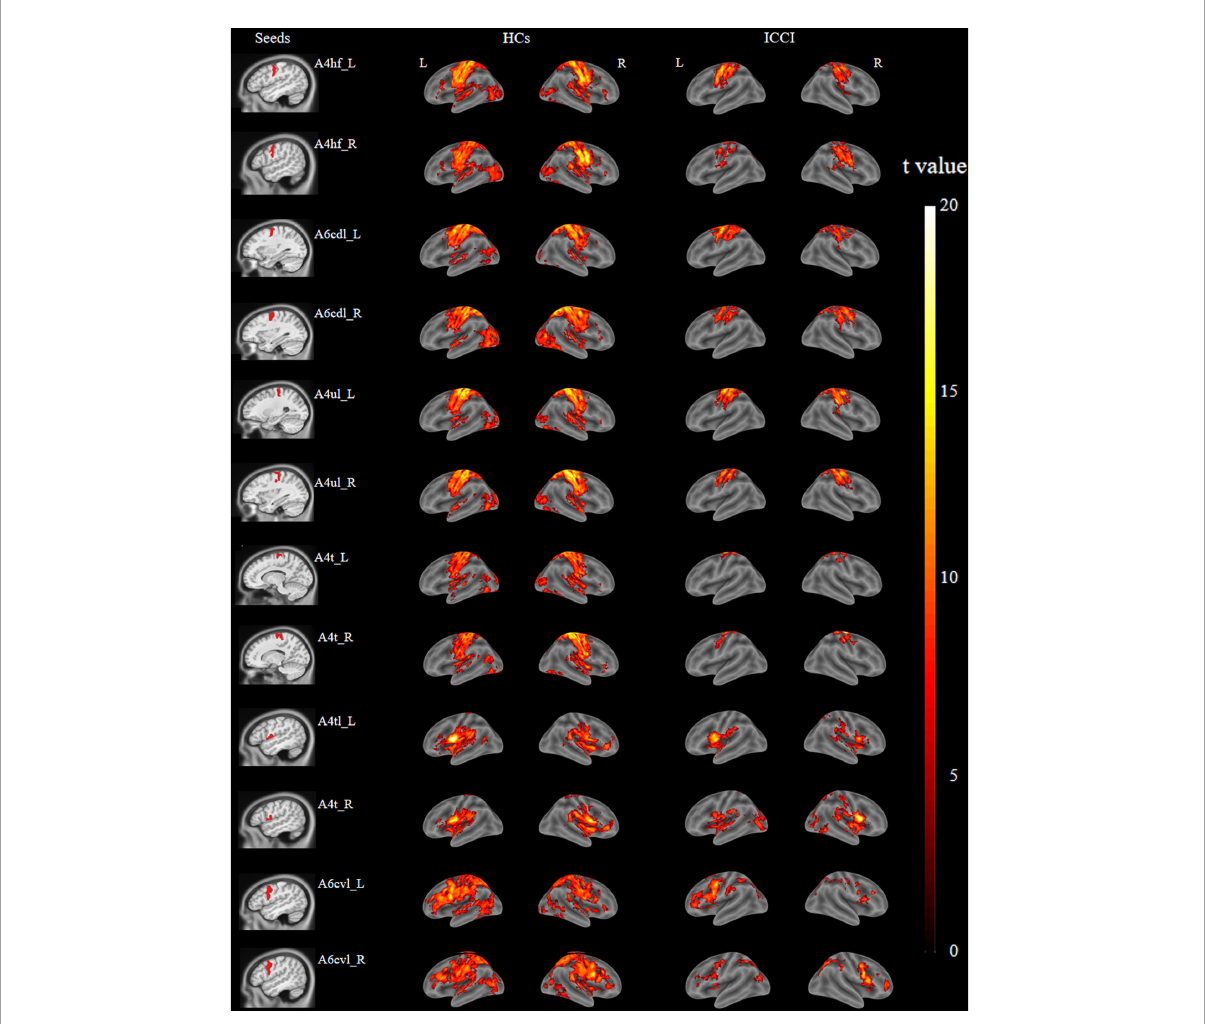
FIGURE2 Brain regions functionally connected to M1 subregions of HCs and ICCI patients. In this figure, displayed the typical brain regions functionally connected to M1 subregions of both groups [family wise error (FWE) corrected P < 0.05 and cluster size > 100 voxels]. M1, primary motor cortex; HCs, healthy controls; ICCI, incomplete cervical cord